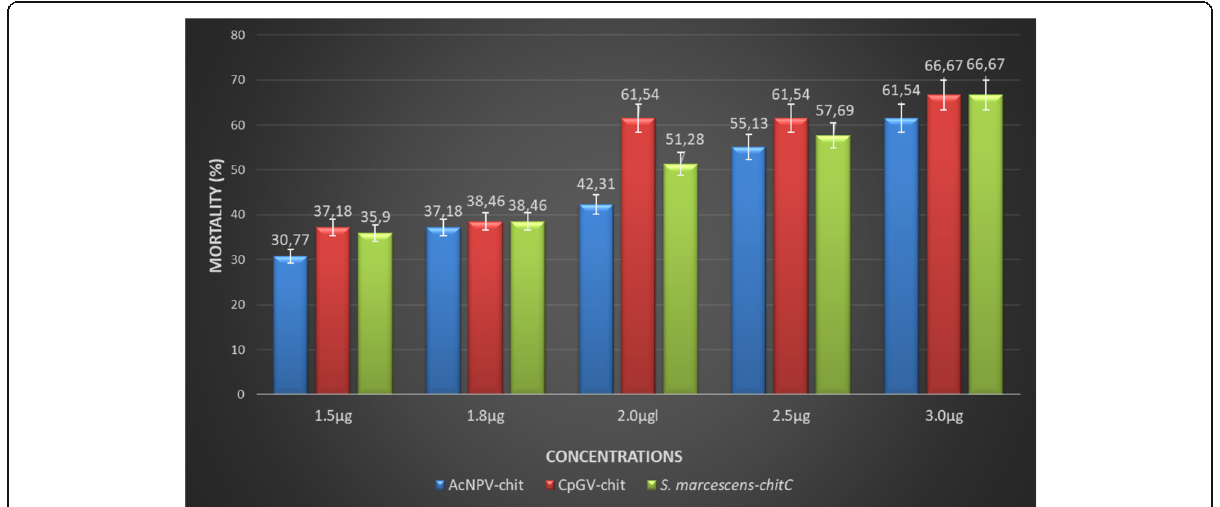
Fig. 5 Insecticidal activity of purified AcNPV-Chi, CpGV-Chi, and Serratia marcescens -ChiC proteins at different concentrations on the 3rd instar Galleria mellonella